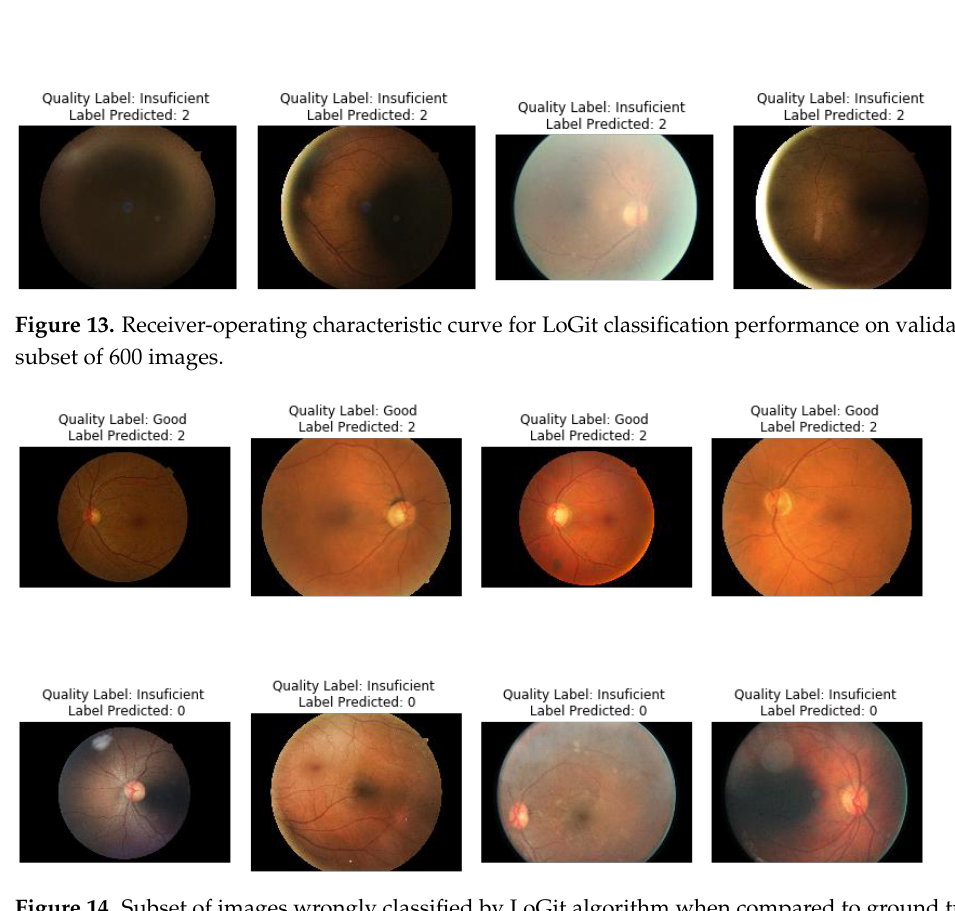
Figure 14. Subset of images wrongly classified by LoGit algorithm when compared to ground